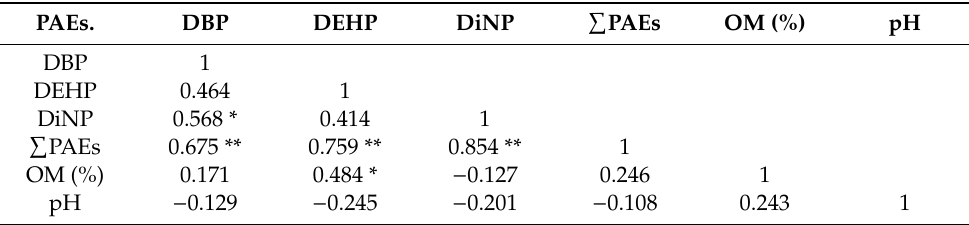
Table 3. Spearman correlation coe ffi